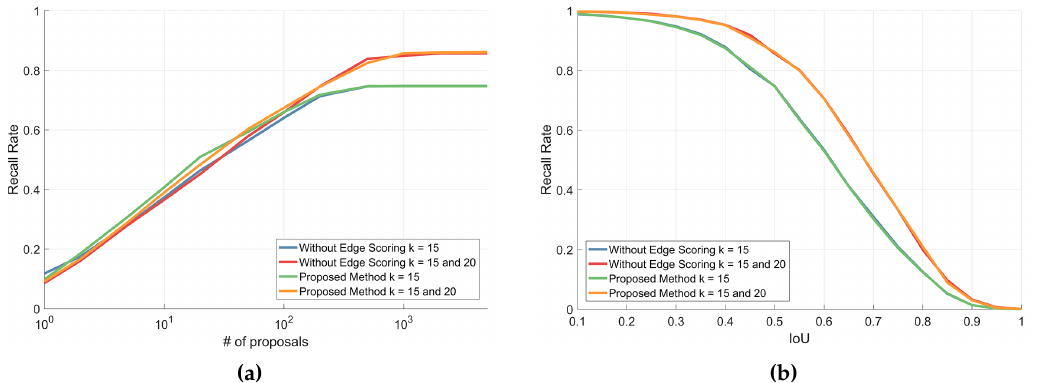
Figure 8. The recall using our method and the variants without utilization of edge scoring. ( a ) the curves measuring the recall versus numbers of ship proposals; ( b ) the curves measuring the recall versus IoU.